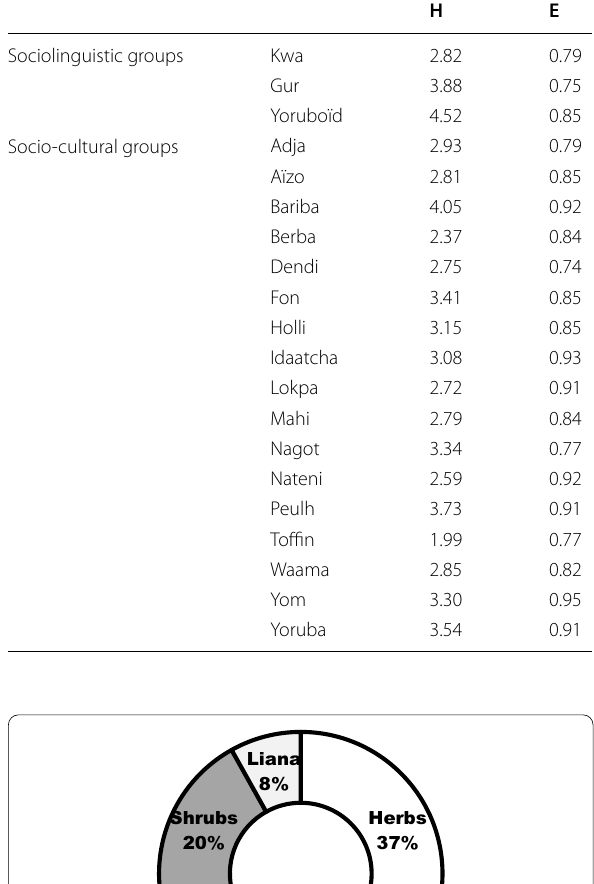
Table 2 Socio-demographic characteristics of respondents Variables